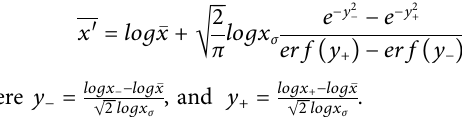
Frontiers in Earth Science |